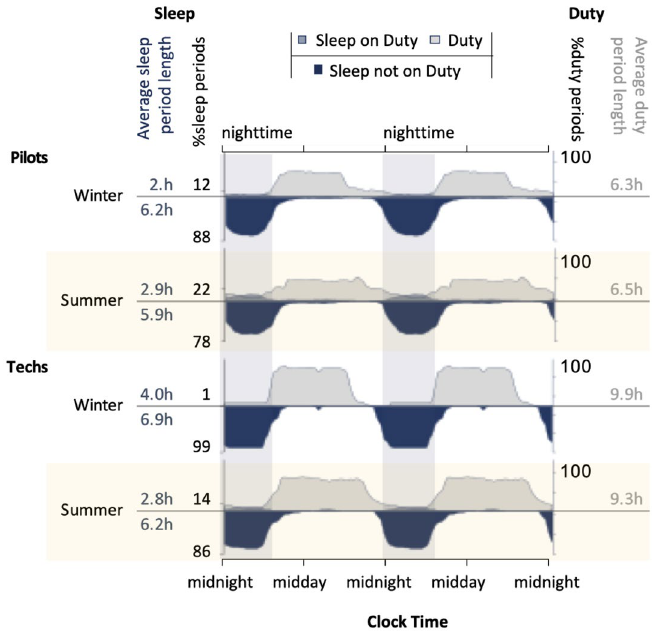
Figure 4. Work and sleep distributions vary as a function of season and job role for pilots and technicians (techs) in Italy. To characterise patterns of work and sleep, the 24 h distributions were double plotted. duty and sleep periods were expressed as a percentage of the total number of periods at that time of day (in 15-min bins). Sleep periods that were associated with duty were plotted, superimposed over duty, with sleep periods outside of duty also represented.